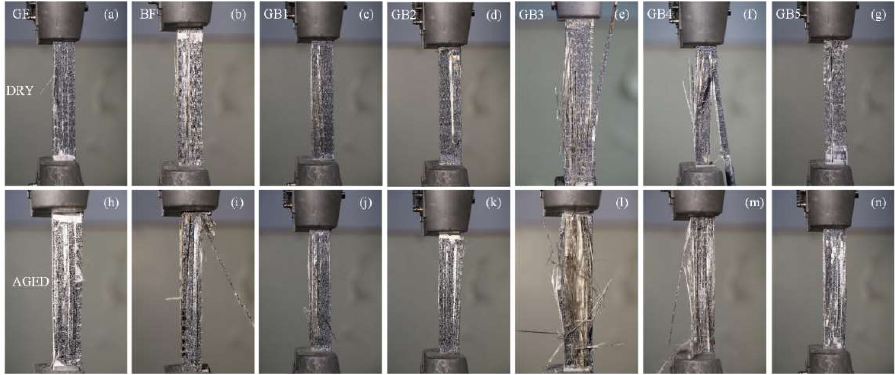
Figure 8. Photograph of tensile test specimens in dry ( a ) GF ( b ) BF ( c ) GB1 ( d ) GB2 ( e ) GB3 ( f ) GB4 ( g ) GB5 and seawater aged condition ( h ) GF ( i ) BF ( j ) GB1 ( k ) GB2 ( l ) GB3 ( m ) GB4 ( n ) GB5